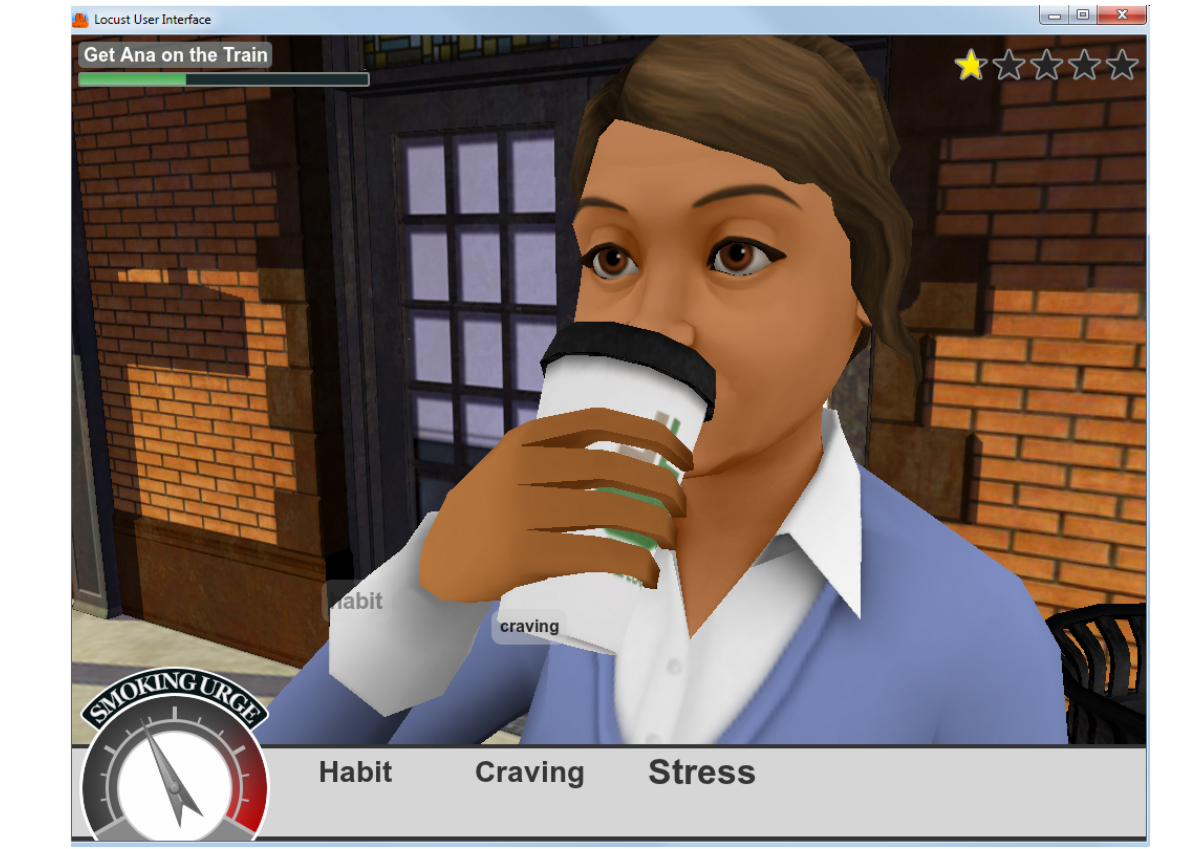
Figure 5. Example of revised game